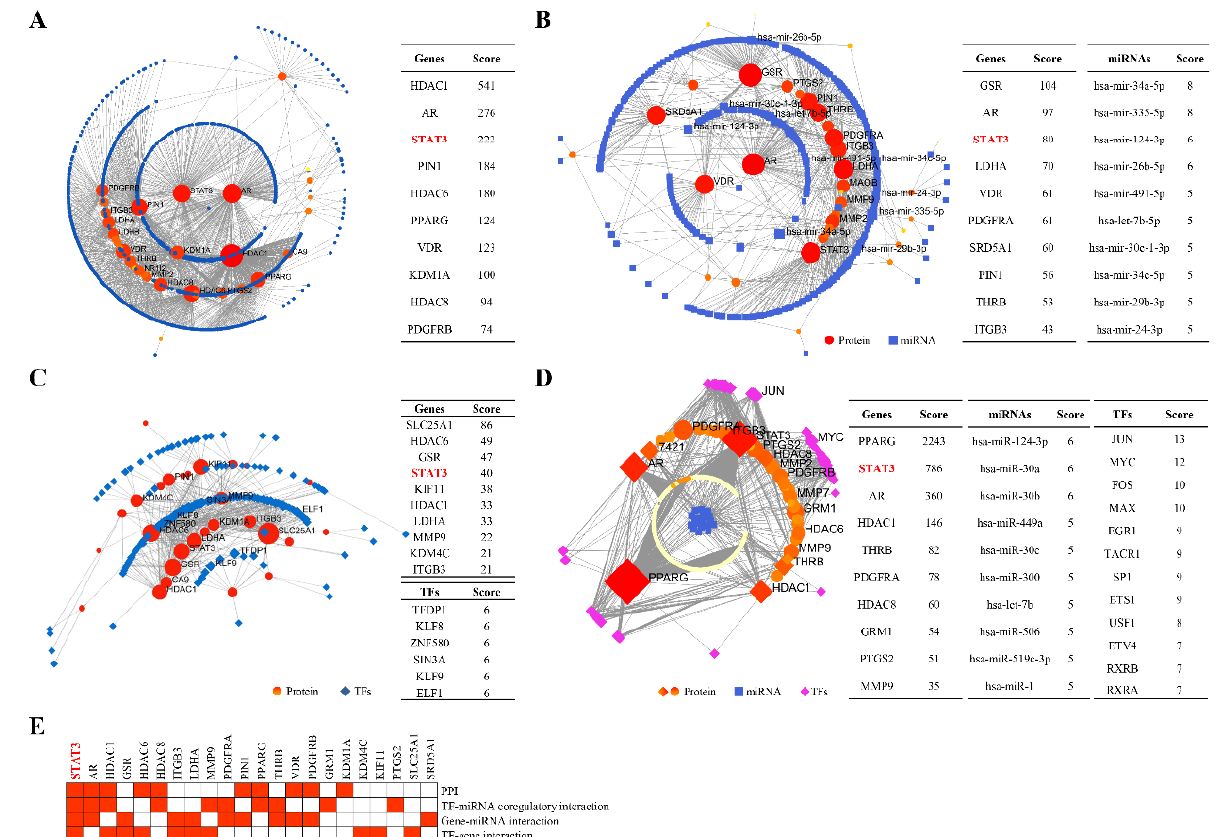
Figure 4. Interactions among genes, regulators, and signalling pathways. The 40 candidate genes were used for interaction analysis. Interactions among genes, TFs, miRNAs, and signalling pathways were analysed using NetworkAnalyst. ( A ) PPIs. The dots were proteins. ( B ) Gene-miRNA interactions. ( C ) TF-gene interactions. ( D ) TF-miRNA coregulatory interactions. ( E ) Ranking of potential key genes.